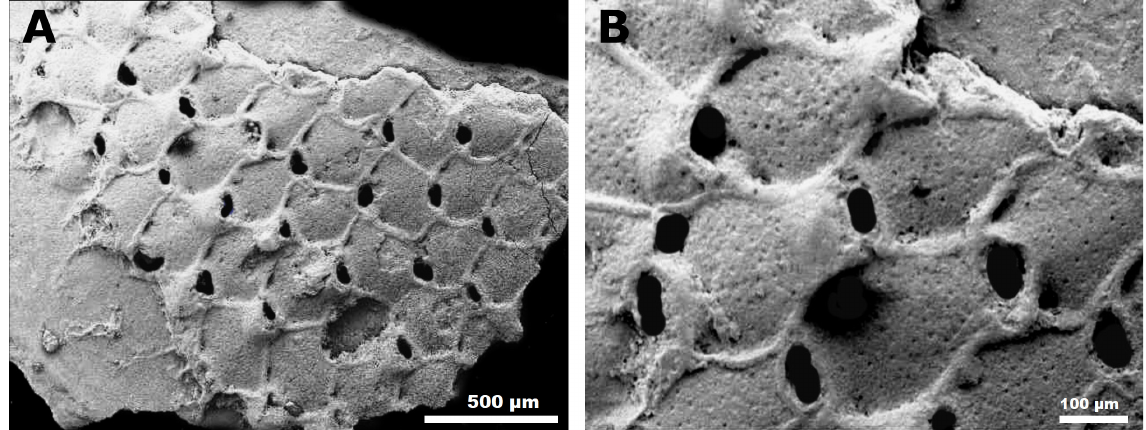
Fig. 9. Micropora vredenburgi Guha & Gopikrishna, 2005 (GIS/B 0516). A . General view of the colony showing subhexagonal autozooid. B . Close-up of an autozooids showing orifices opesia, opesiules, thick mural rims and